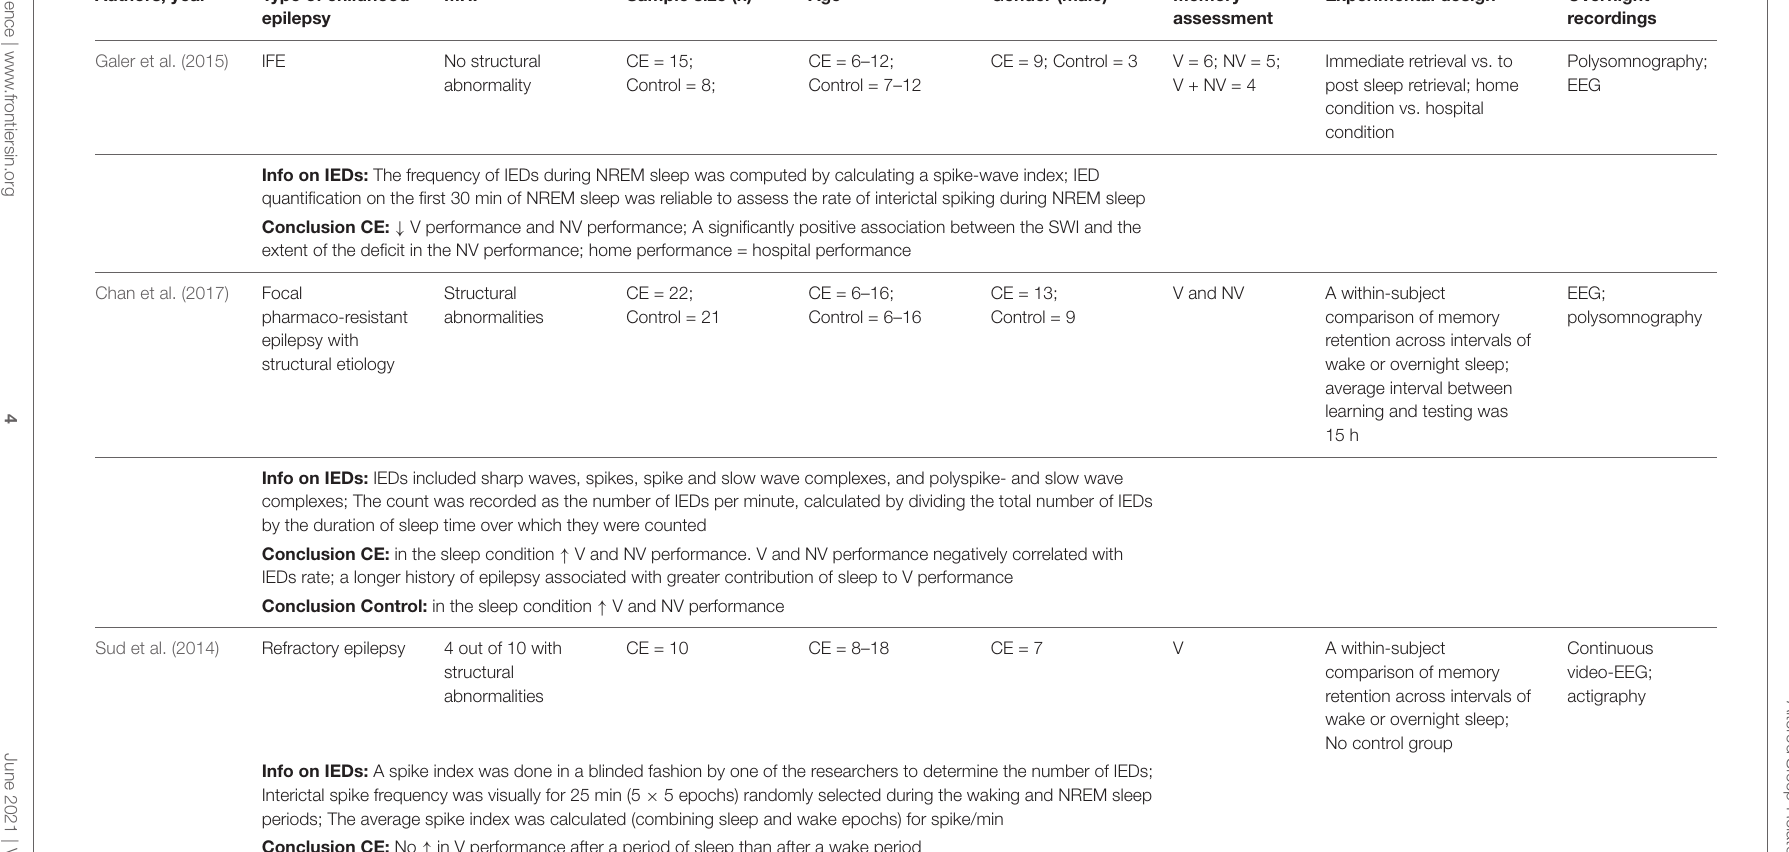
TABLE 1 | Studies on IEDs and SRC performance in childhood epilepsy. Authors,